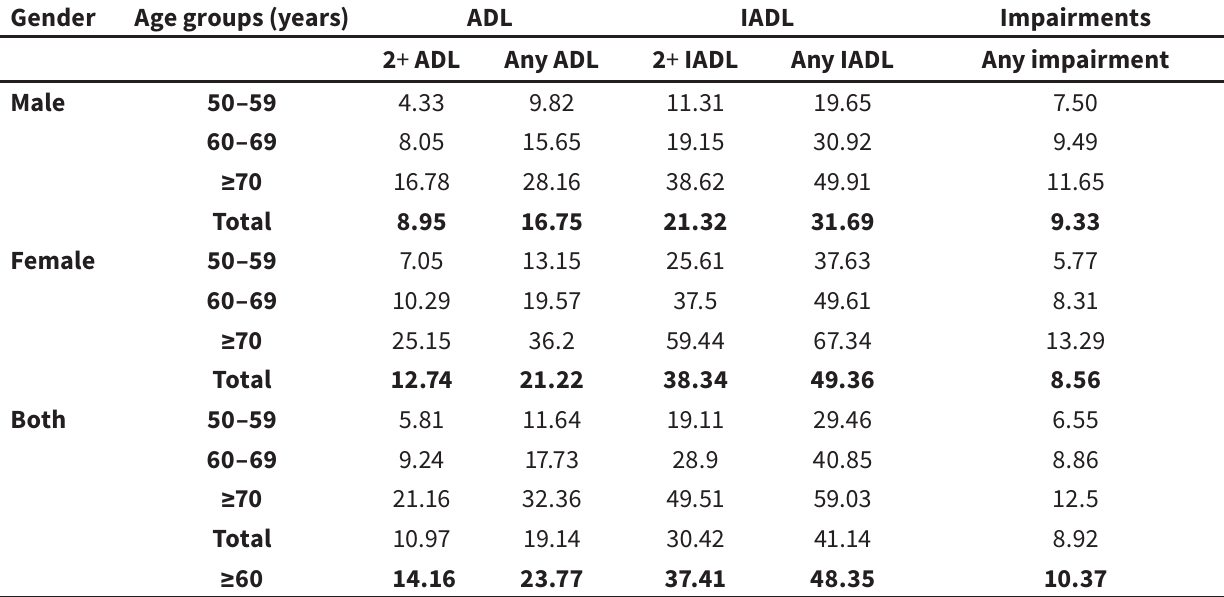
Functional health of the aging population in India